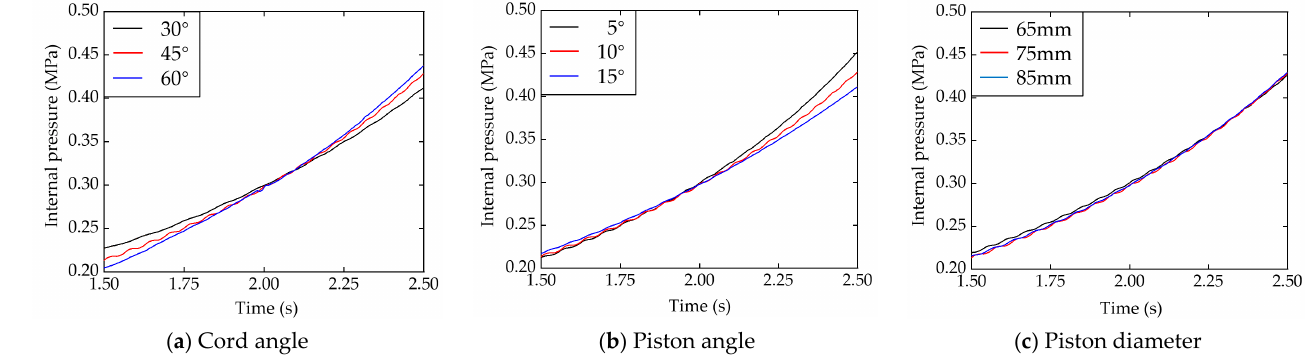
Figure 10. The deformation of bellows under different cord angle.